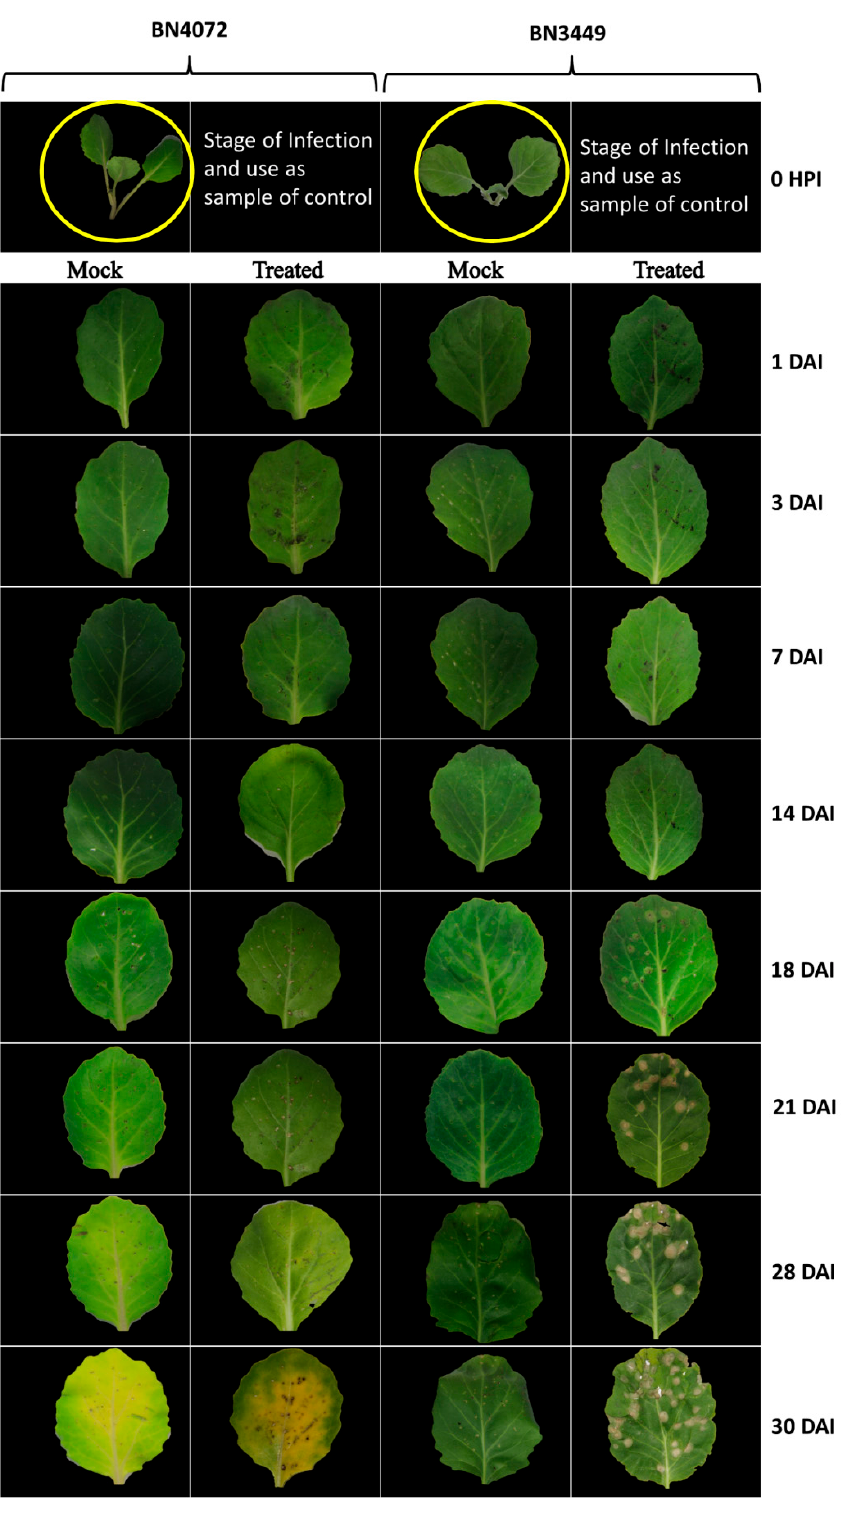
Figure 1. Ringspot disease progress in R line BN4072 and S line BN3449 of cabbage. Plants were infected at the three-leaf stage (yellow circles). Infected leaves were examined from 1–30 DAI (days after inoculation). HPI (Hours post inoculation), R: Resistant; S: Susceptible.